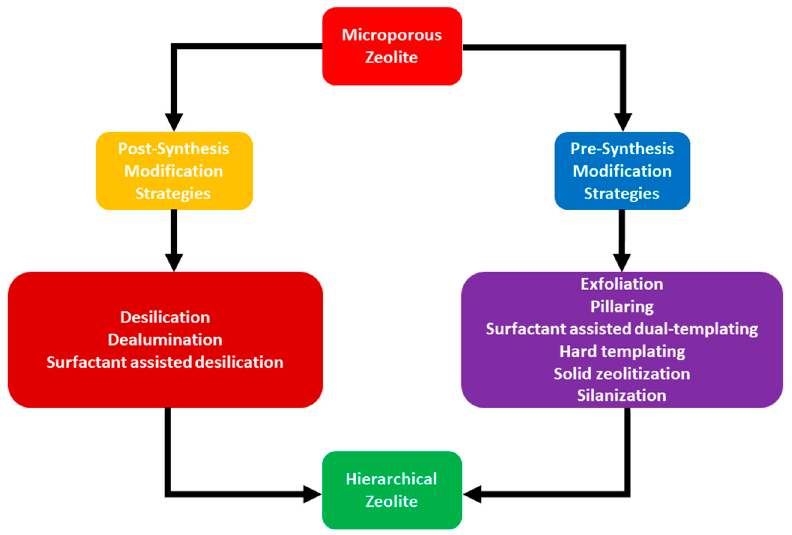
Figure 1. The schematic representation of various hierarchical zeolite formation strategies.